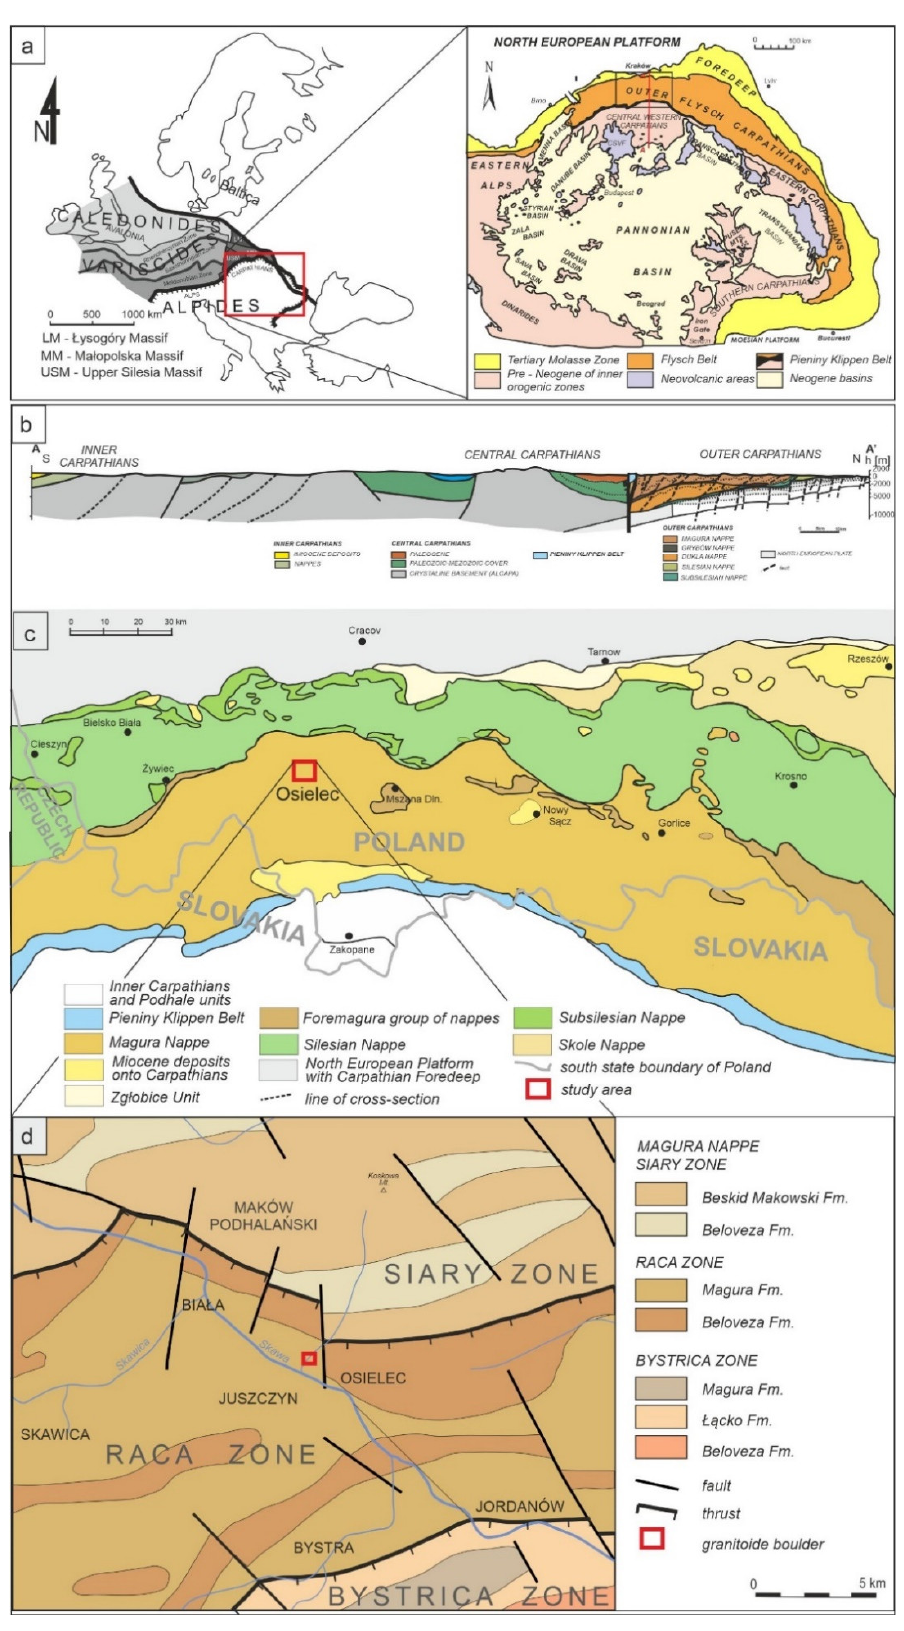
Figure 1. ( a ) A simplified geological sketch of the Carpathian chain within Europe; ( b ) generalized cross-section through the Western Carpathians (modified from [1]); ( c ) the simplified geological map of the Outer Western Carpathians and ( d ) the study area with the locations of the sampling point.